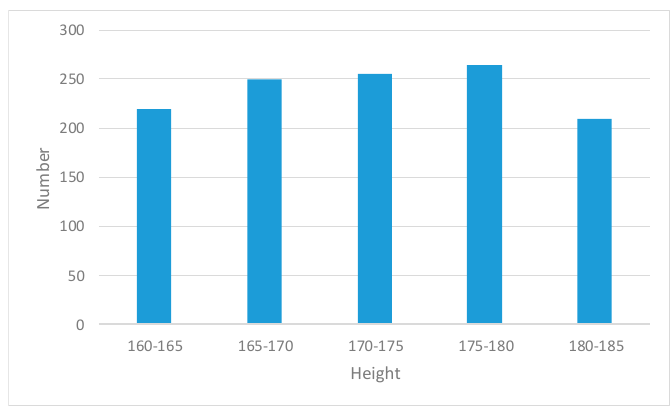
Figure 6. The age and gender distribution of volunteers.